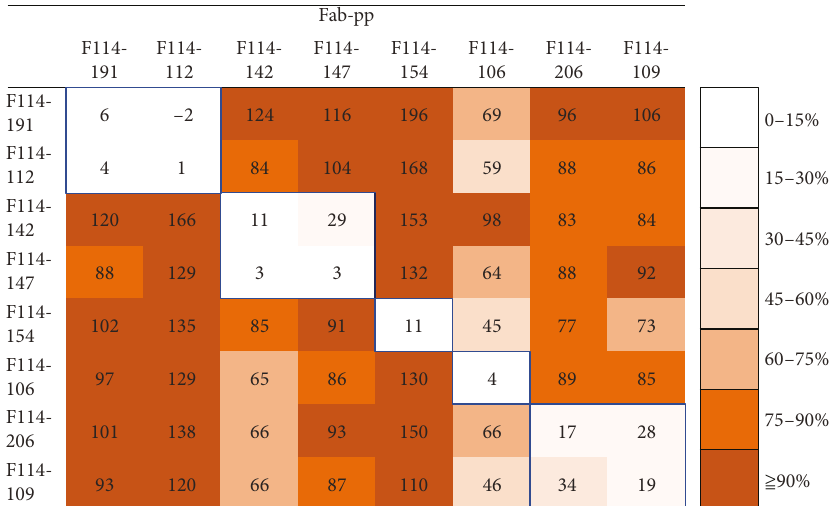
Figure 8: Competitive ELISA among isolated clones. The binding activity of Fab-PP Ab (indicated at the top) to B/Massachusetts/2/2012 virus particles was measured by ELISA in the presence of a 10-fold greater concentration of Fab-cp3 Ab (indicated at the left). F008-009, which is not an anti-HA Ab, was used as a control. The binding activity of Fab-PP in the presence of Fab-cp3 Ab was indicated as relative values as follows: the absorbance value in the presence of F008-009cp3 was set as 100% binding and the binding activity in the presence of various Fab-cp3 forms of Abs is indicated as % values.